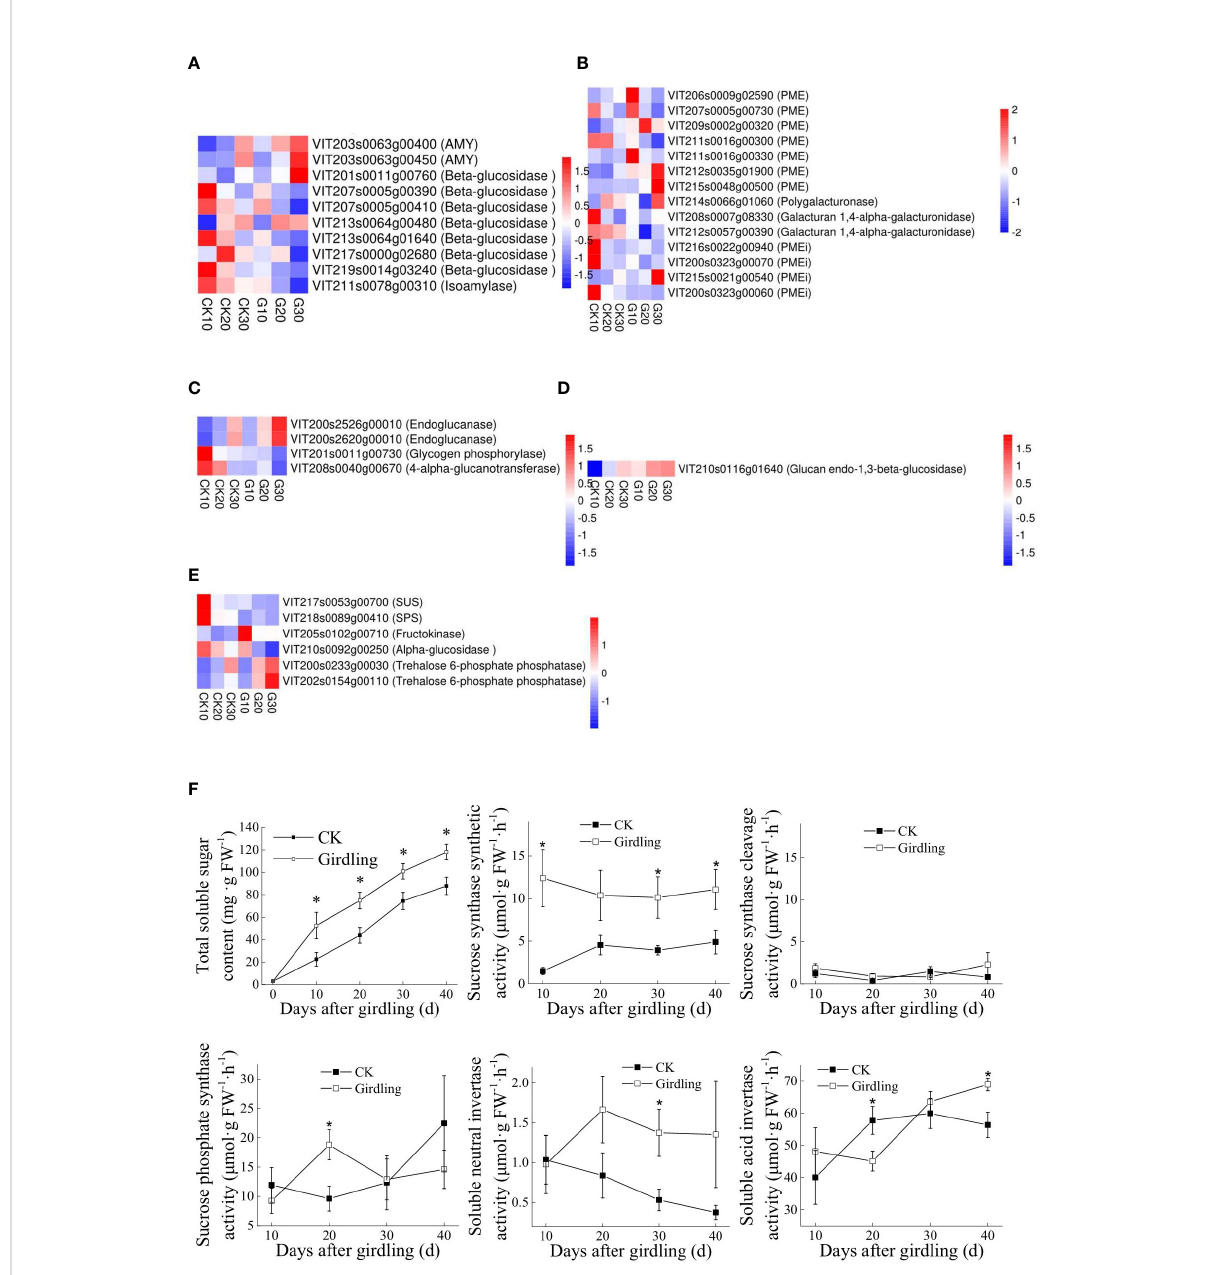
FIGURE 7 Effects of girdling on polysaccharide degradation and disaccharide metabolism. (A – F) Expression patterns of DEGs associated with starch degradation (A) , pectin degradation (B) , cellulose degradation (C) , 3-beta- D -glucan hydrolysis (D) , and disaccharide metabolism (E) are as heatmaps. TPMs of genes were used in the analysis after row z-score scaling. DEGs are labeled by gene ID (description). AMY, alpha-amylase; SUS, sucrose synthase; DEGs, differentially expressed genes; TPMs, transcripts per million reads. (F) Total SSC and activity of enzymes participating in sucrose metabolism. SSC, soluble sugar content. *p < 0.05 vs. control on the same day